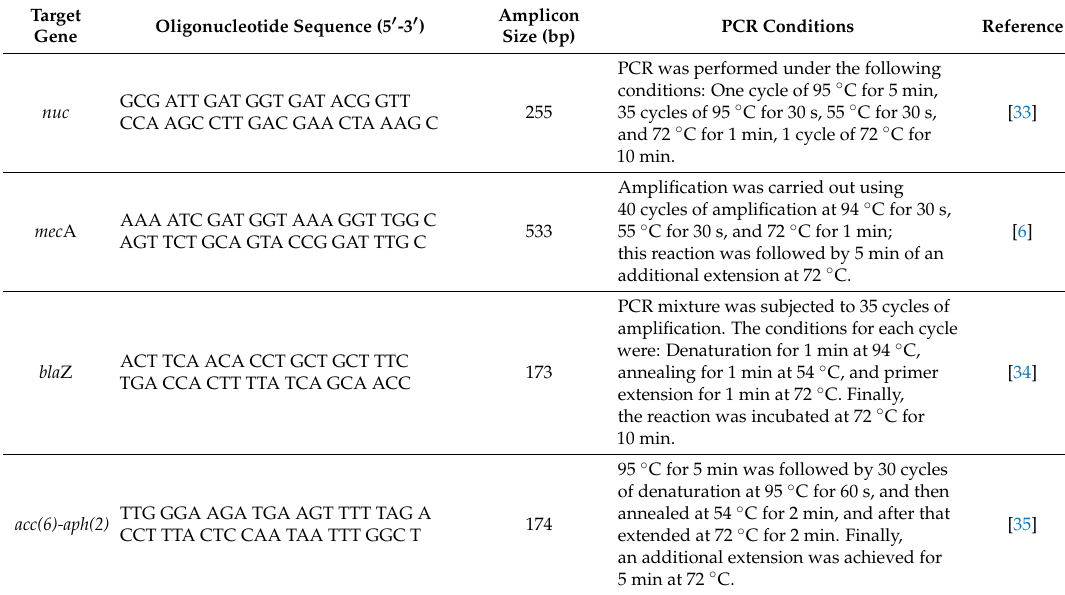
Table 1. Oligonucleotide sequences used for polymerase chain reaction in the identification of Staphylococcus aureus and detection of antibiotic resistance